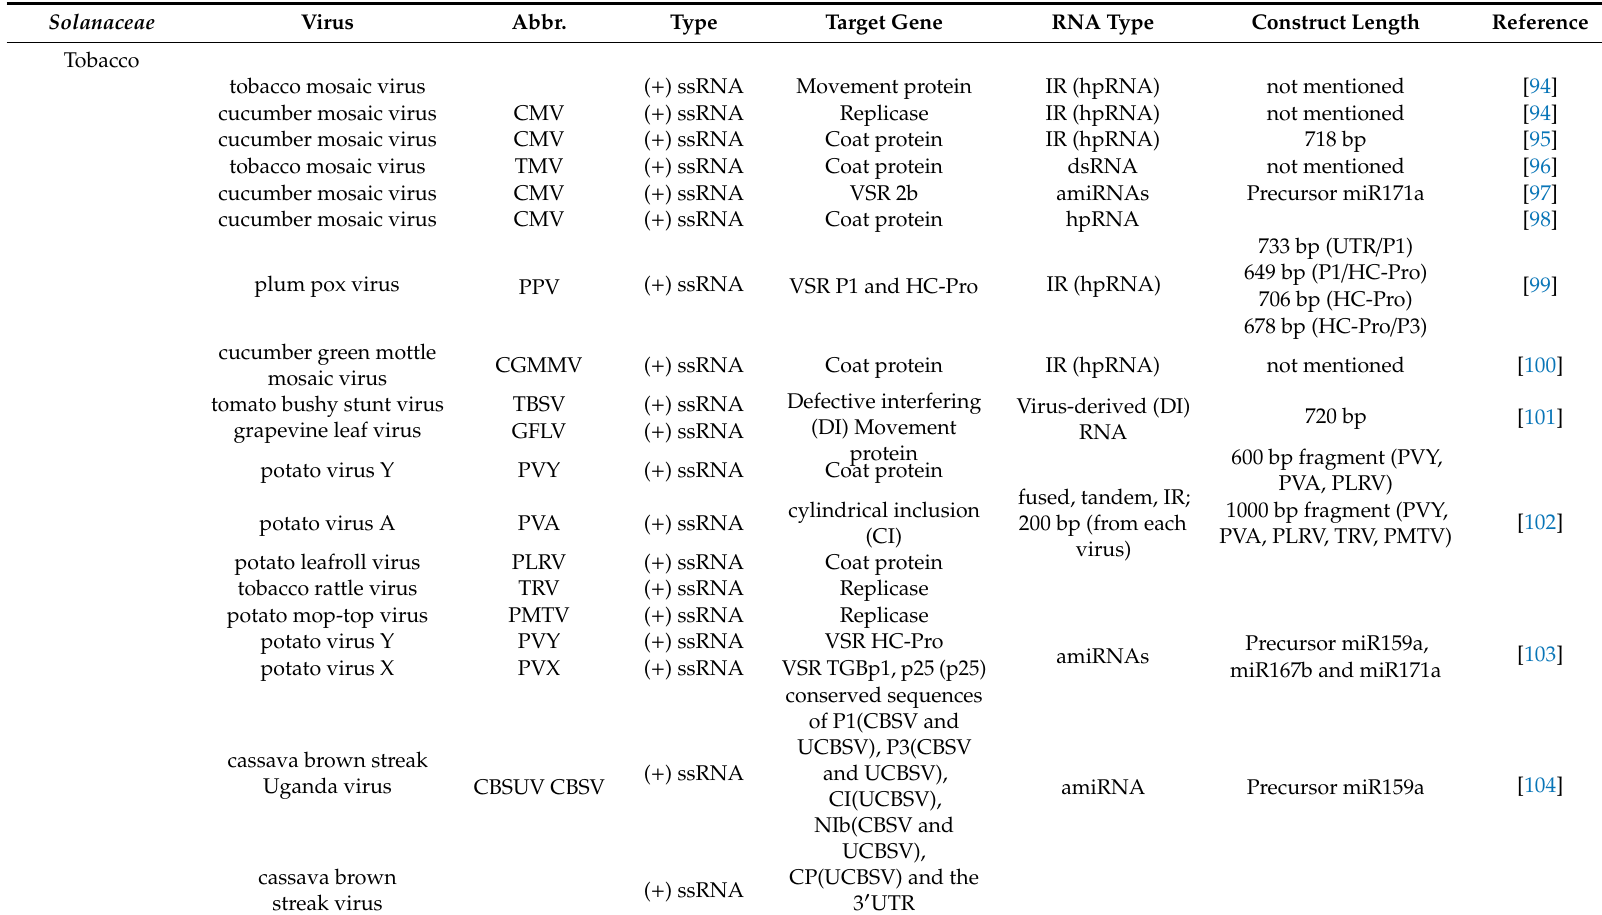
Table 1. Summary of HIGS applied to control viral pathogens. Host plant family, virus species and genome, target genes, type of RNA silencing trigger and construct length are summarized Hairpin RNA (hpRNA); artificial miRNA